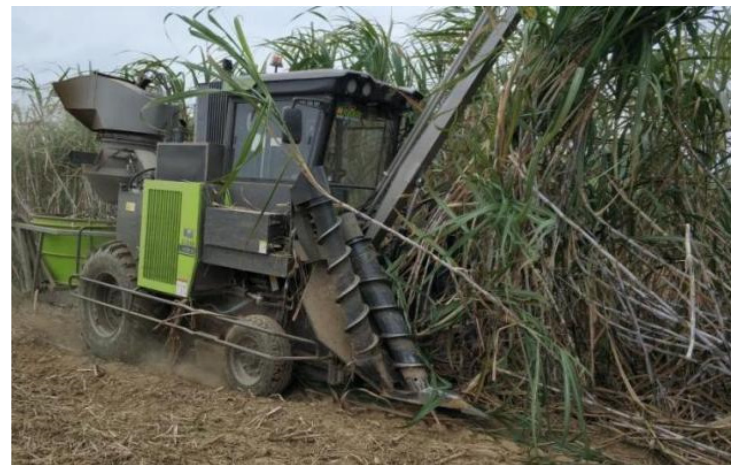
Figure 7. Field validation tests. Table 2. Comparison of simulation and field test results.